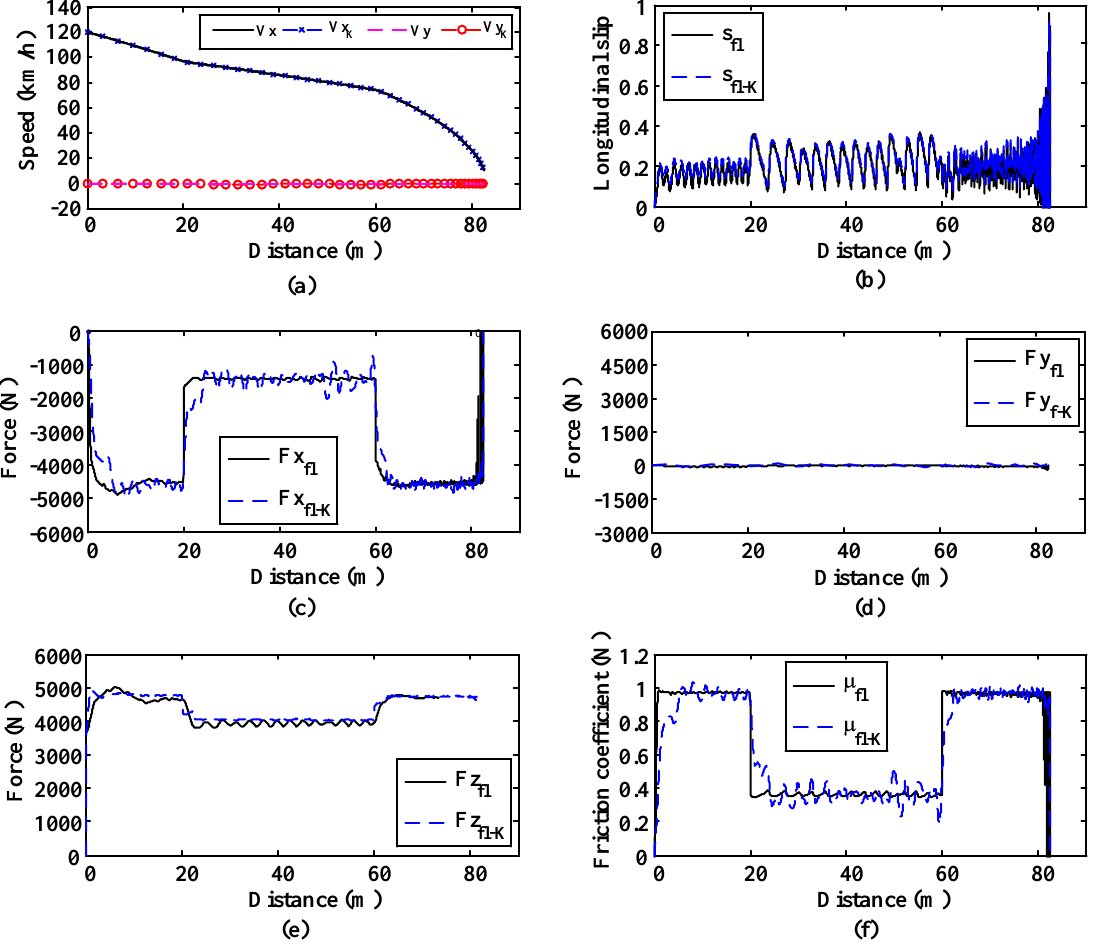
Figure 11. Straight line simulation. Surface transition: 20 m. on µ = 1, 40 m. on µ = 0.4 and 40 m. on µ = 1. ( a ) Longitudinal and lateral speed; ( b ) Longitudinal slip; ( c ) Longitudinal forces; ( d ) Lateral forces; ( e ) Vertical forces; ( f ) Friction coefficient.